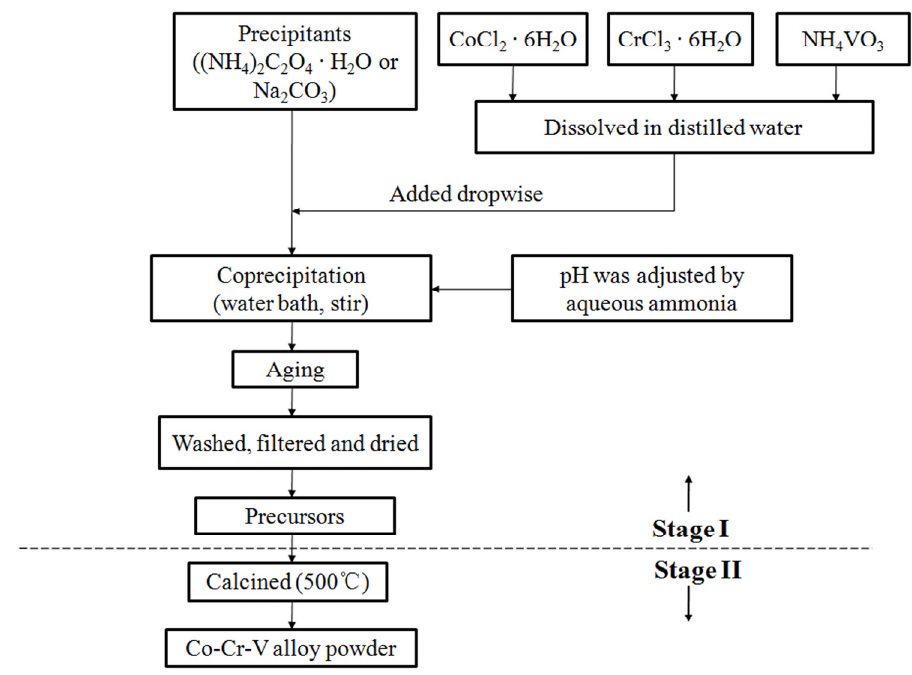
Figure 1. Flow chart of synthesis.